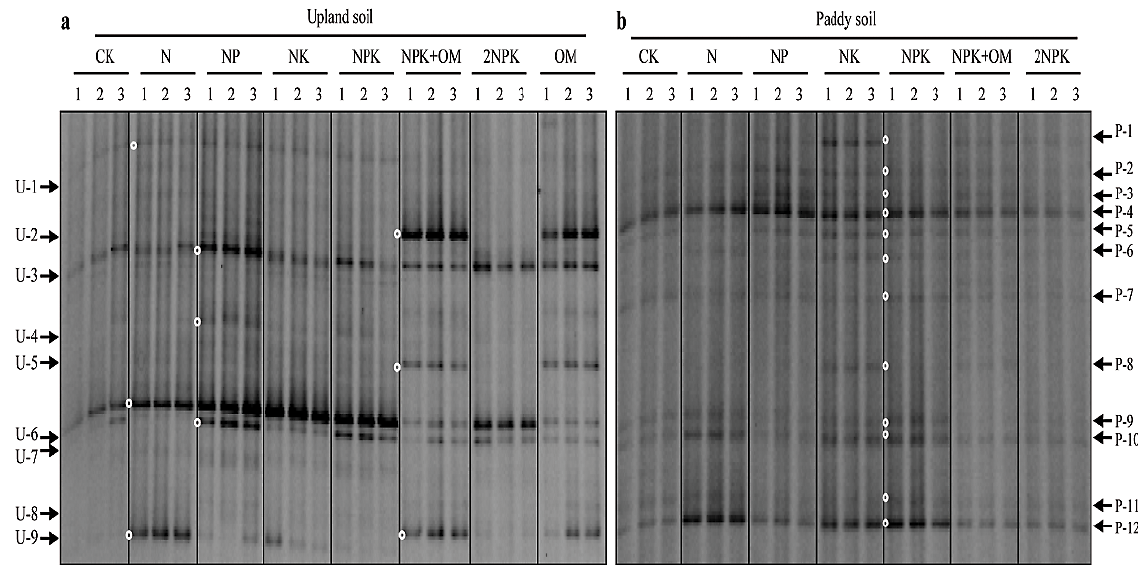
Fig. 5. DGGE fingerprints of archaeal amoA genes derived from upland soil (a) and from paddy soil (b) . Designations for the treatments are the same as those stated in Fig. 1. The arrows indicate DGGE bands excised for sequencing. Lanes 1, 2 and 3 represent three replicated plots for each treatment.